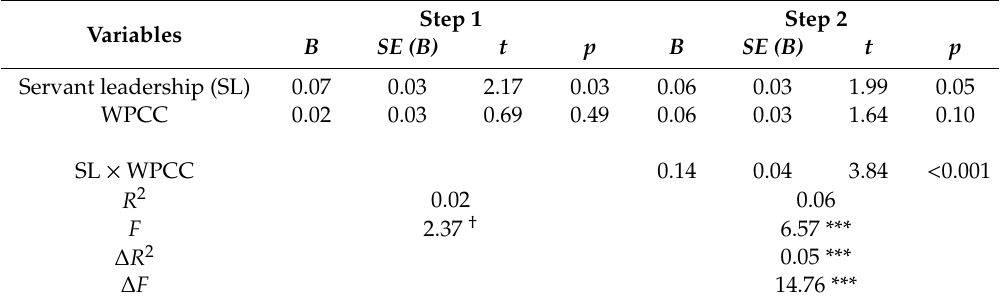
Table 2. Moderation of WPCC on the relationship between servant leadership and